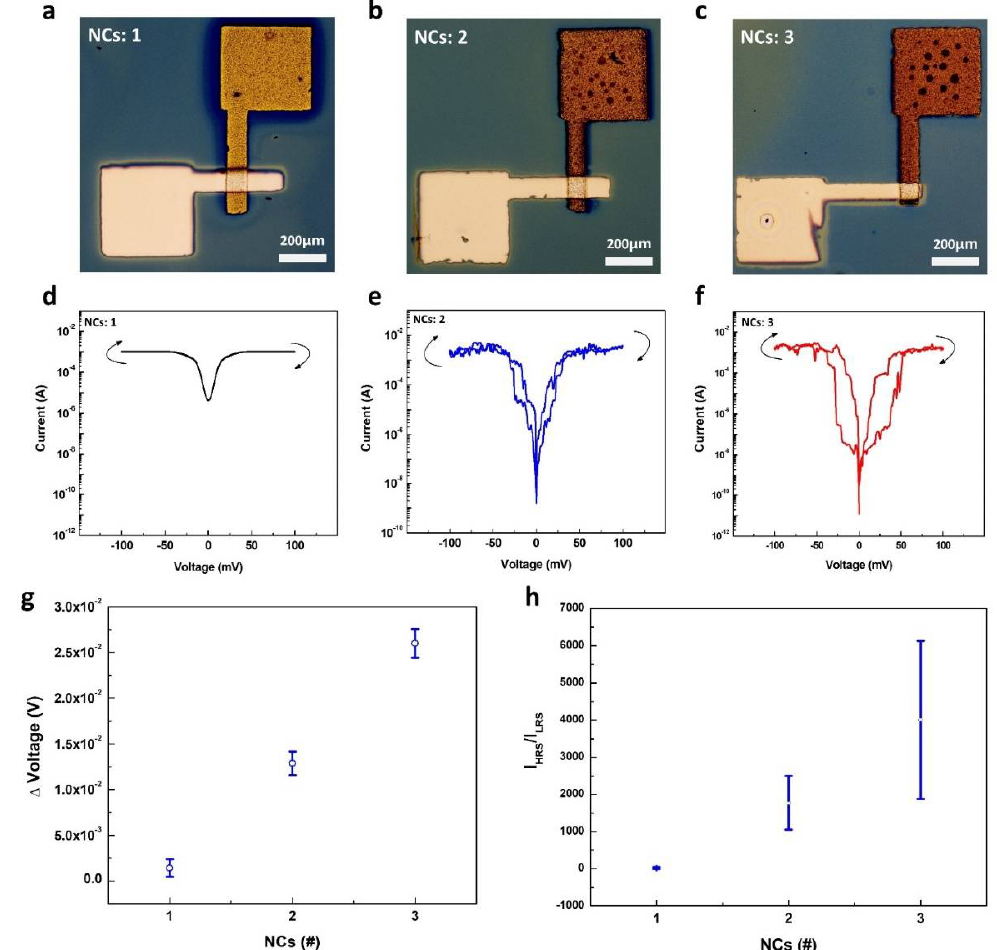
Figure 8. Optical microscopy image of metal-CTO-metal devices varied with the number of coatings ( a ) NCs: 1, ( b ) NCs: 2, ( c ) NCs: 3. I–V curve of metal-CTO-metal devices depending on the number of CTO coatings ( d ) NCs: 1, ( e ) NCs: 2, ( f ) NCs: 3. The plots of the ( g ) memory window and ( h ) switching current ratio.